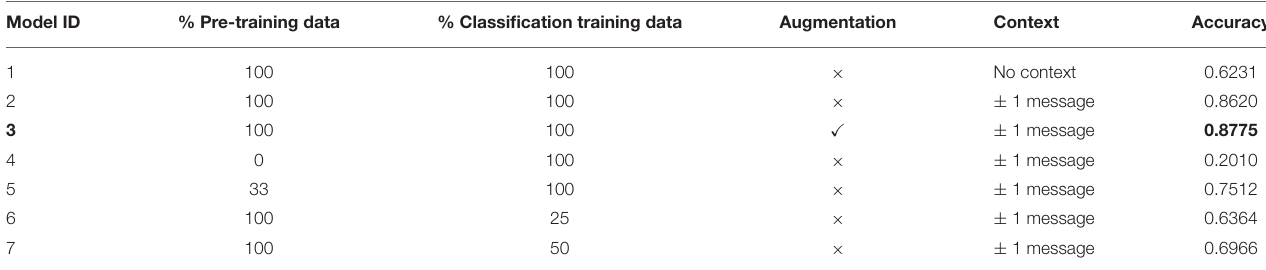
TABLE 3 | Comparison of conversation stage classification performance for models with different performance improvement techniques. Model ID